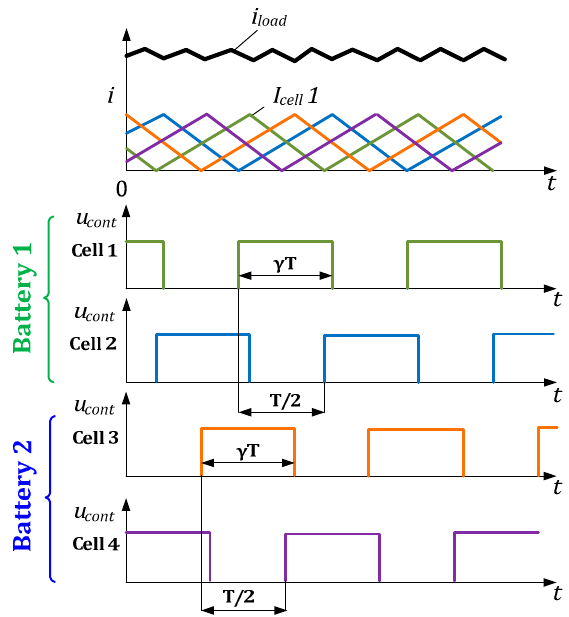
Figure 6. Generalized operation principle of a multi-cell interleaved SEPIC converter.